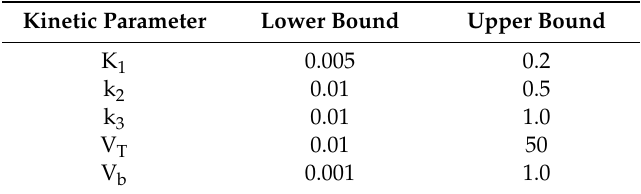
Table 2. Parameter boundaries used during non-linear regression analysis.